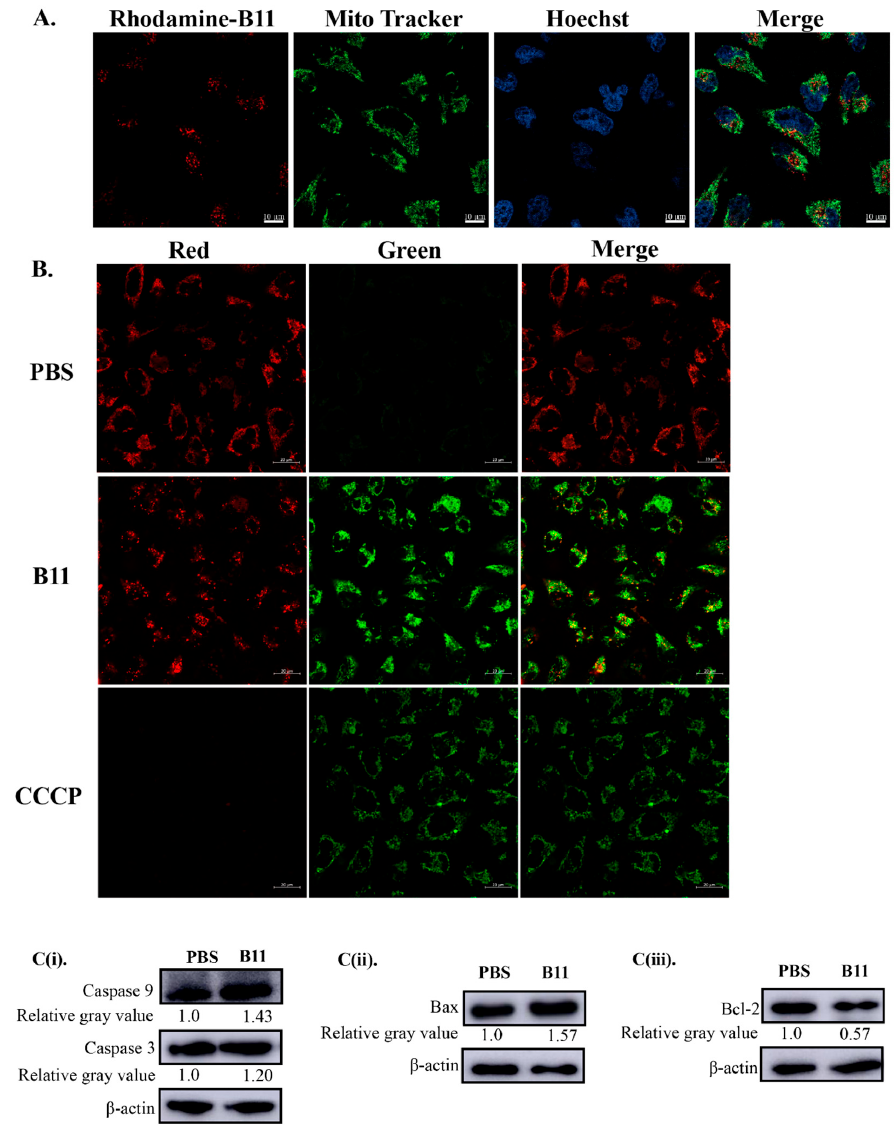
Figure 5. Localization of peptide B11 in the mitochondria, its effect on mitochondrial membrane potential ( ∆Ψ m), and apoptosis induction in HeLa cells. ( A ) Microscopic images showing the intracellular localization of rhodamine-labeled B11 in HeLa cells. Cells were treated with 50 μ g/mL of rhodamine-labeled B11 for 8 h, washed with PBS and stained with 200 nM of MitoTracker Green. Images were captured with a confocal microscope under a 40× objective (scale bar = 10 μ m). ( B ) Mitochondrial membrane potential ( ∆Ψ m) of HeLa cells treated with peptide B11. Cells were treated for 24 h with peptide B11 (50 μ g/mL) and PBS (0.01 M, pH 7.4), followed by staining with 5,5 ′ ,6,6 ′ -tetrachloro-1,1 ′ ,3,3 ′ -tetraethylbenzimidazole-carbocyanide iodine (JC-1) working solution and incubated for 20 min at 37 °C protected from light. Images were observed under confocal microscopy (scale bar = 20 μ m). For positive control, cells were treated with 10 μ M of carbonyl cyanide m-chlorophenylhydrazone (CCCP). Red fluorescence represents the mitochondrial aggregate form of JC-1, indicating an intact mitochondrial membrane potential. Green fluorescence represents the monomeric form of JC-1, indicating dissipation of the ∆Ψ m. ( C ) Immunoblots of ( i ) caspase-9 and caspase-3, ( ii ) Bax, and ( iii ) Bcl-2 protein levels in peptide B11-treated HeLa cells analyzed by Western blot. Cell lysates from HeLa cells treated with peptide B11 (50 μ g/mL) or PBS (0.01 M, pH 7.4) for 24 h were analyzed using the appropriate antibodies, with β -actin used as a loading control. Numbers below the blots represent the relative gray values determined using ImageJ